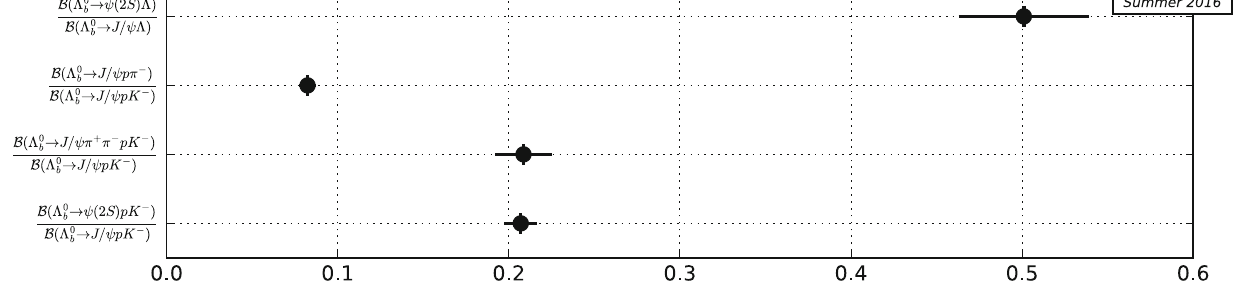
Fig. 170 Summary of the averages from Table 210